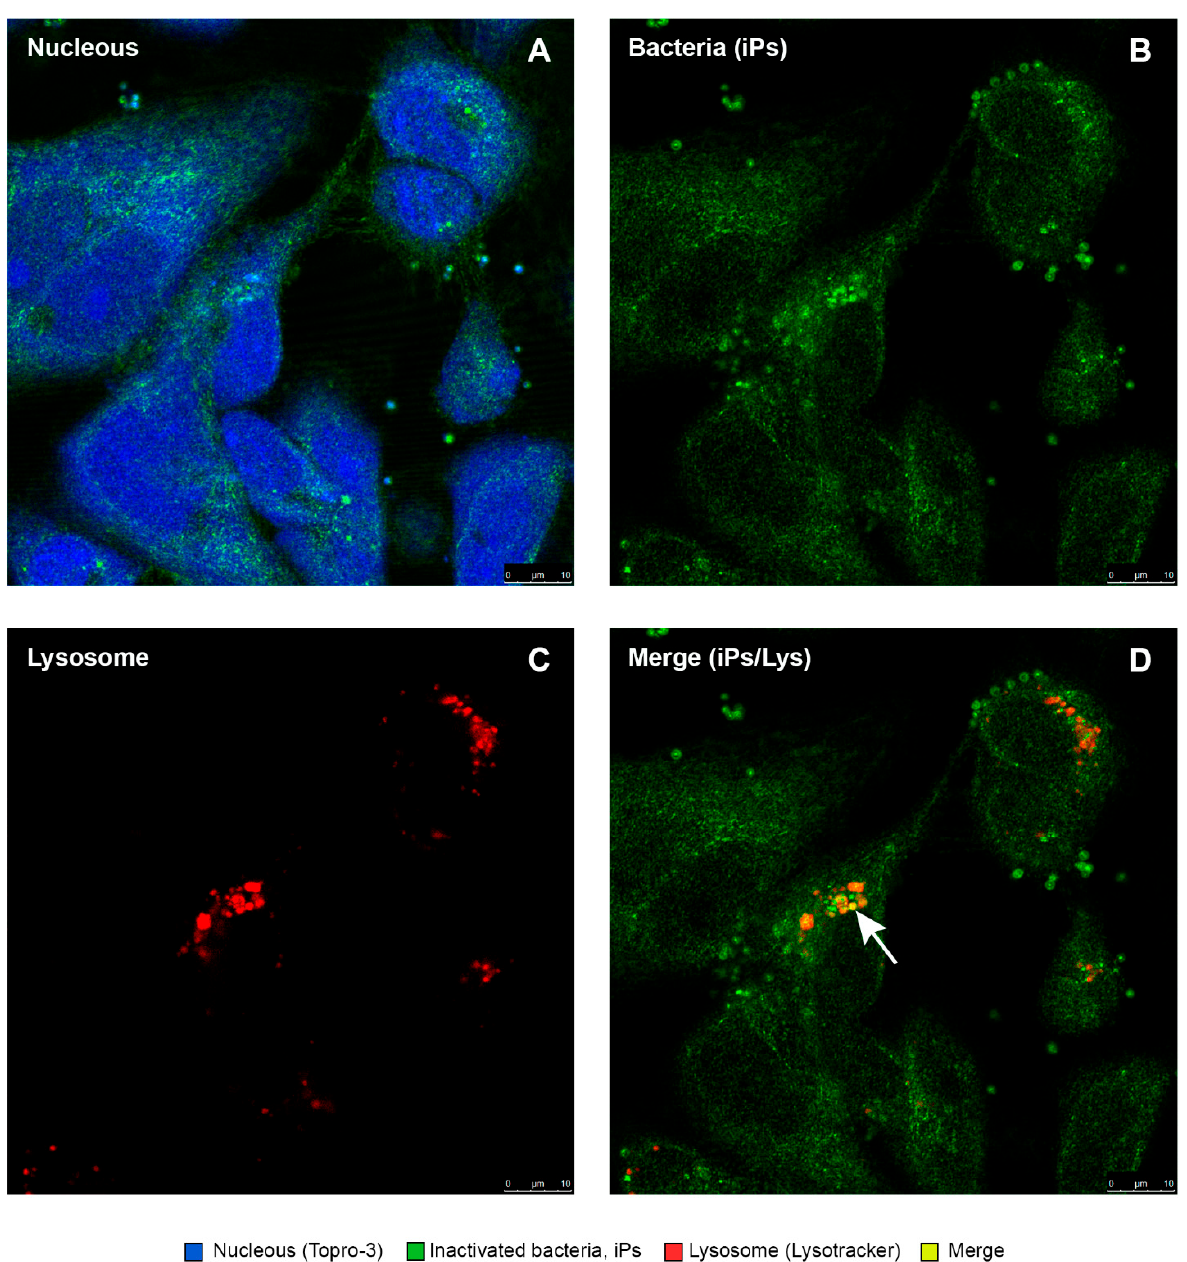
Figure 11. Intracellular colocalization of inactivated P. salmonis in SHK-1 cells. ( A ) The blue color shows the nuclei of the cells marked with TOPRO-3. ( B ) The green color shows inactivated bacteria (iPs). ( C ) Lysosomes were observed and are marked with Lysotracker Red DND-99. ( D ) The colocalization of the iPs within lysosomes is displayed in a yellow-orange color. This colocalization is a sign of phagosome–lysosome fusion.